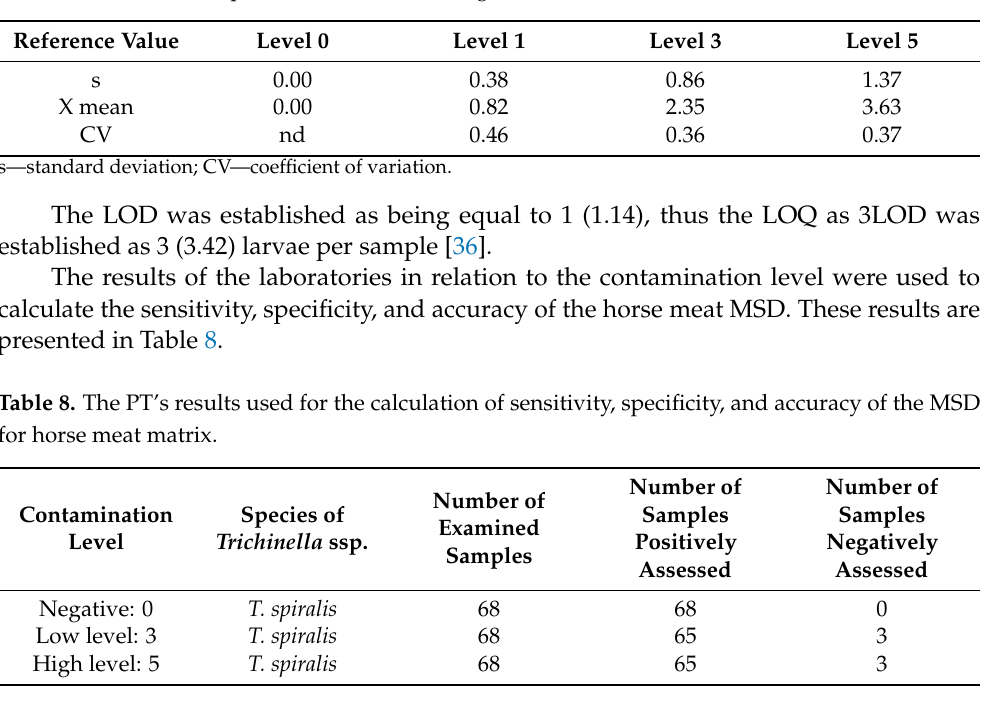
Table 7. A low CV% indicates the very good precision of laboratory performance and the examined reference samples; CV values lower than 25% indicates very low variability of reported results. Table 7. Assessment of parameters characterizing the PT results.